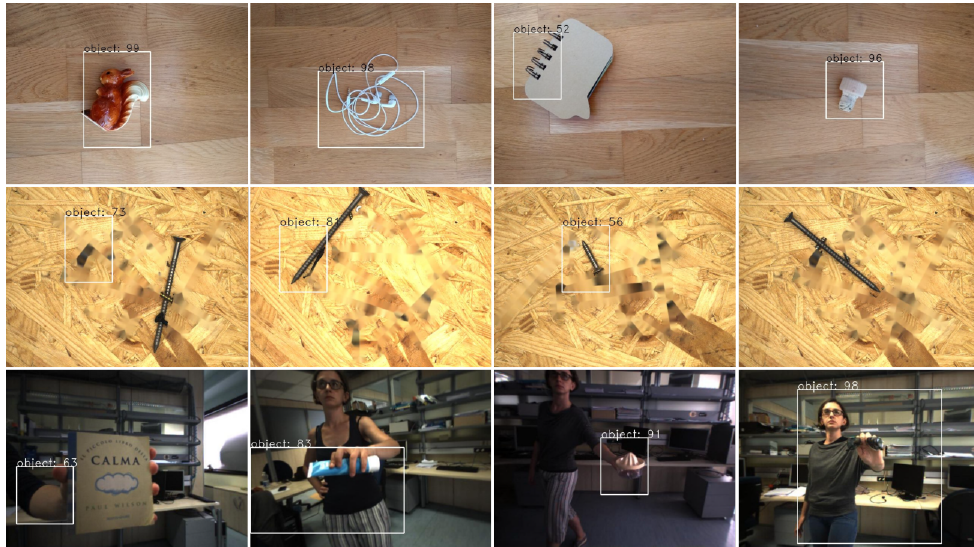
Figure 9. Inference results of the Faster R-CNN annotation model F + trained on the fruits dataset for 200 epochs and applied to different datasets. The images in the first row are taken on a wooden floor, the second row contains images that have been modified from the original MVTec Screws dataset [74], and the last row shows examples from the iCubWorld data test. Figure adapted from our recent work [8]. Table 2. Comparison with LOST [11]. The inference results of the F + model (at epoch 200) on the fruits test dataset are shown in comparison to application of the unsupervised object discovery method LOST on the same dataset. The Faster R-CNN-based model F + achieves better results than LOST (87% vs. 65% correct bounding box predictions). The inference time is much smaller for F + on a CPU (Intel(R) Iris(R) XE Graphics) than for the LOST model on a GPU (NVIDIA GeForce MX450). F + LOST [11] Correct prediction 87% 65%